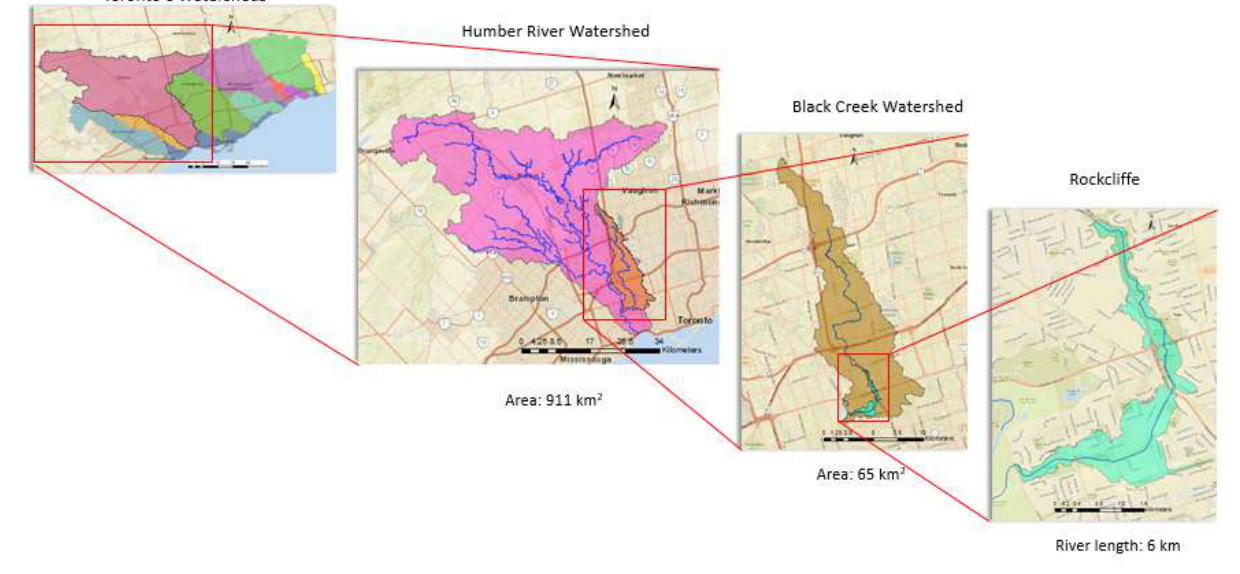
Figure 2. Study area: Rockcliffe region within the Black Creek subwatershed.